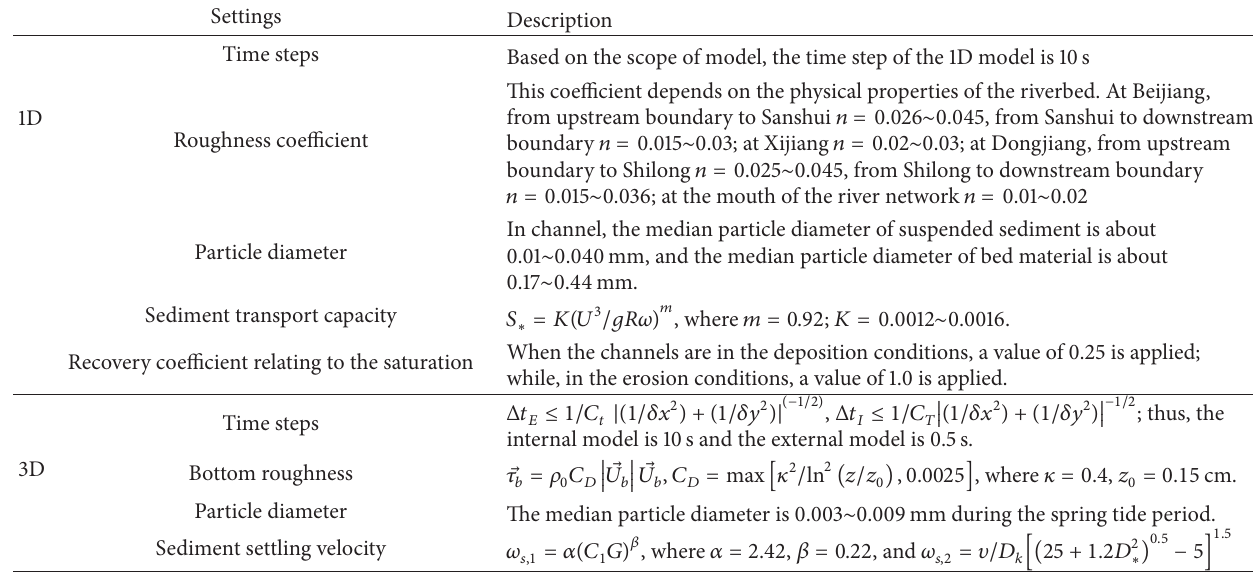
Table 1: Parameters of the modeling.